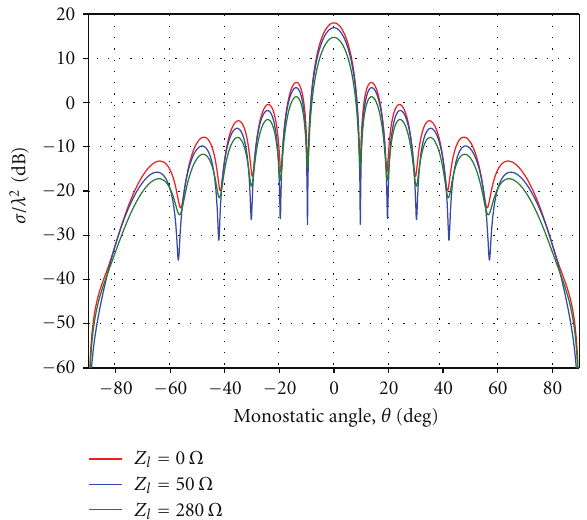
Figure 23: E ff ect of terminating impedance on RCS of series-fed linear array including mutual coupling e ff ect. N = 30, “ θ s = 0 ◦ ”, ψ = π/ 2, l = 0 . 5 λ , d = 0 . 1 λ , a = 10 − 5 λ , and Z Dolph-Chebyshev distribution for side-by-side